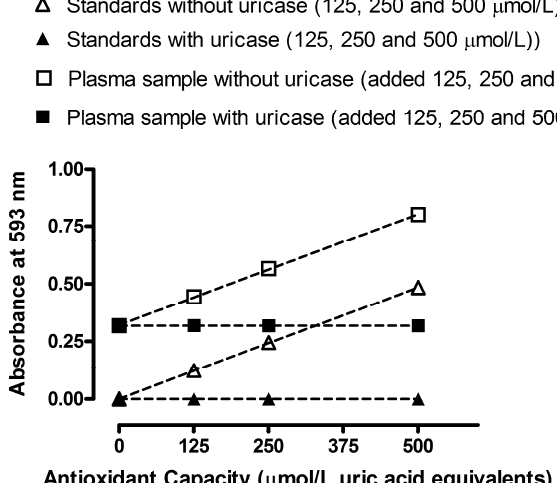
Figure 3. Absorbance readings vs. antioxidant capacity of uric acid standards (without and with uricase treatment) combined with standard addition experiment performed on human plasma (without and with uricase treatment). All data are expressed as means ± SD. All measurements for each sample were done in